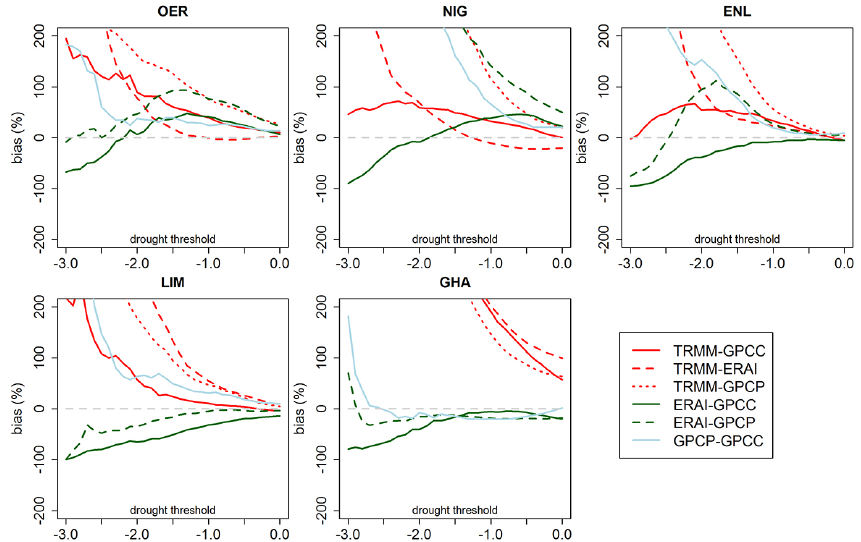
Fig. 10. Relative bias between the estimation of fractional areas under drought for different data sets and thresholds. The horizontal axis represents the SPI threshold below which areas are considered to be under